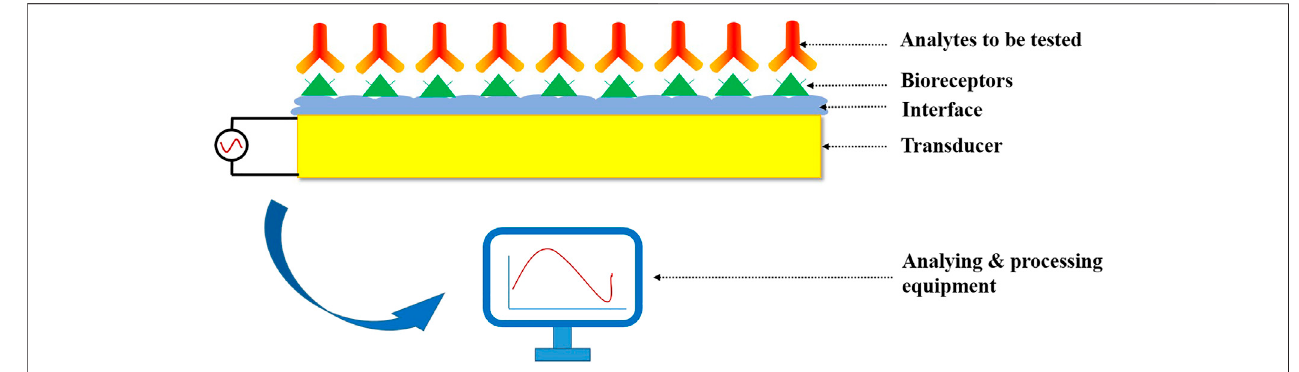
FIGURE 1 | The structure of a